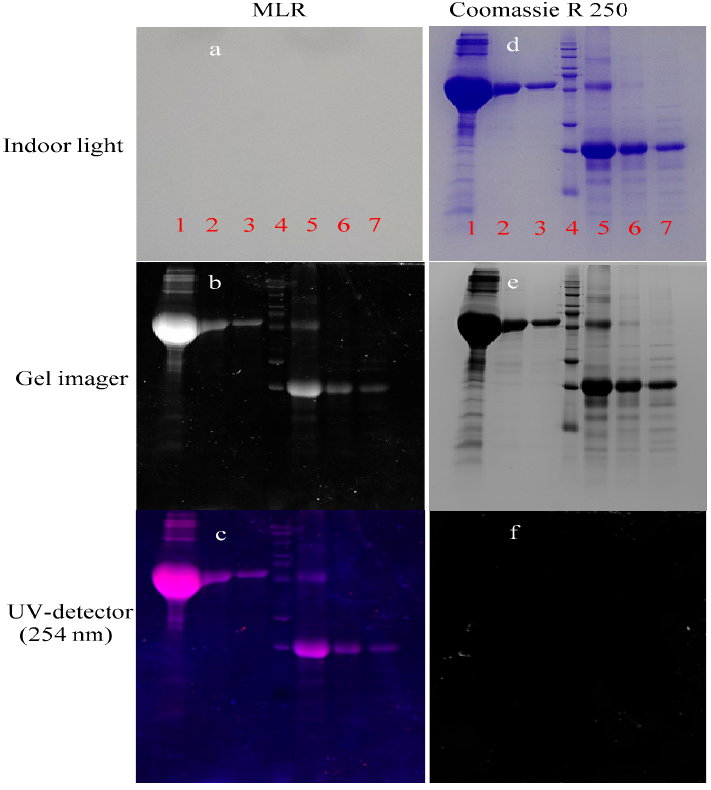
Figure 7. Fluorescence imaging of proteins in electrophoresis gels. ( a – c ): The expressed proteins and their inclusions in electrophoresis gels stained with MLR. (Lane 1–7: 1. Bacterial total proteins containing Ecallantide; 2. Supernatant solution containing Ecallantide; 3. MarTX separated by Ni-column and eluted without imidazole; 4. MarTX separated by Ni-column and eluted with 100 mM/L imidazole; 5. MarTX separated by Ni-column and eluted with 500 mM/L imidazole; 6. A total of 100 mM/L Ecallantide; 7. Protein ruler). ( d – f ): The same protein samples in electrophoresis gels stained with Coomassie brilliant blue R 250.